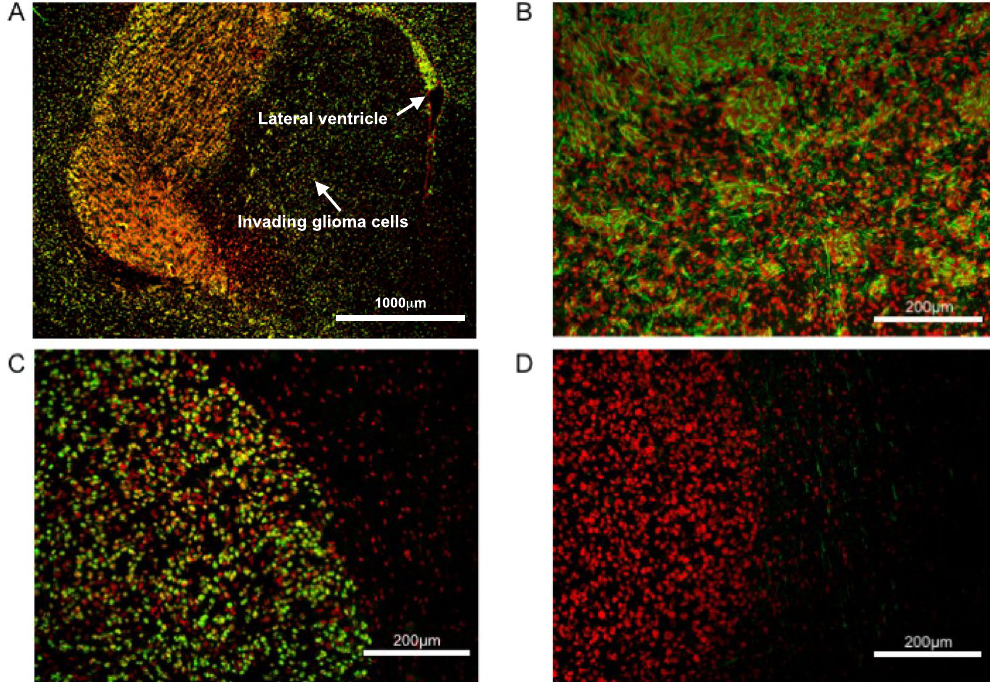
Figure 2. Characteristics of orthotopic xenotransplants derived from primary GBM cell cultures propagated in serum-free ( A , B ) and serum containing ( C , D ) media. ( A and C ) Detection of human glioma cells by an antibody against human nuclei (in green). ( B and D ) Detection of GFAP expression (in green). ToPro3 was used for nuclear counterstaining (red).